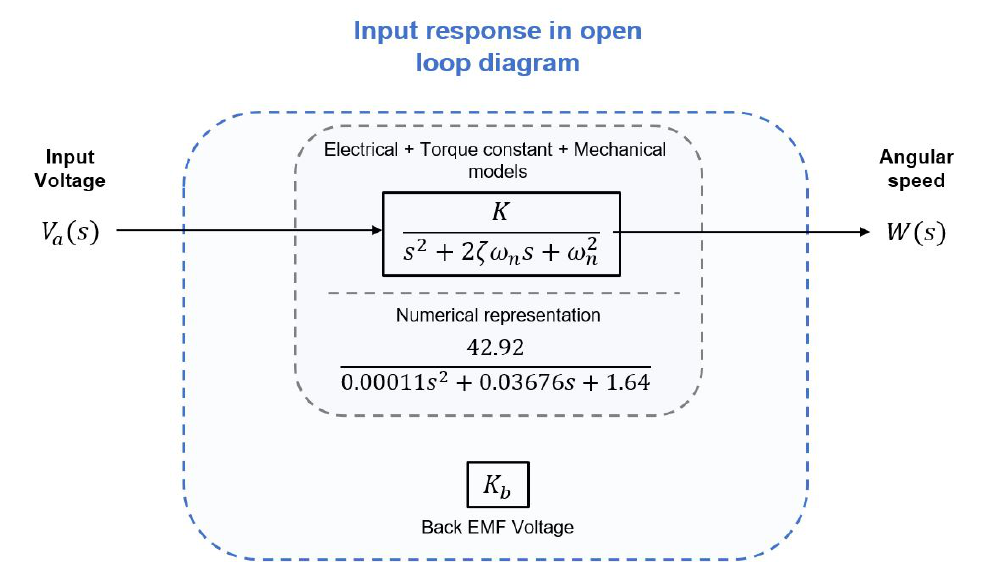
Figure 3. Simplified transfer function in open loop. The Back EMF K b is disconnected from the